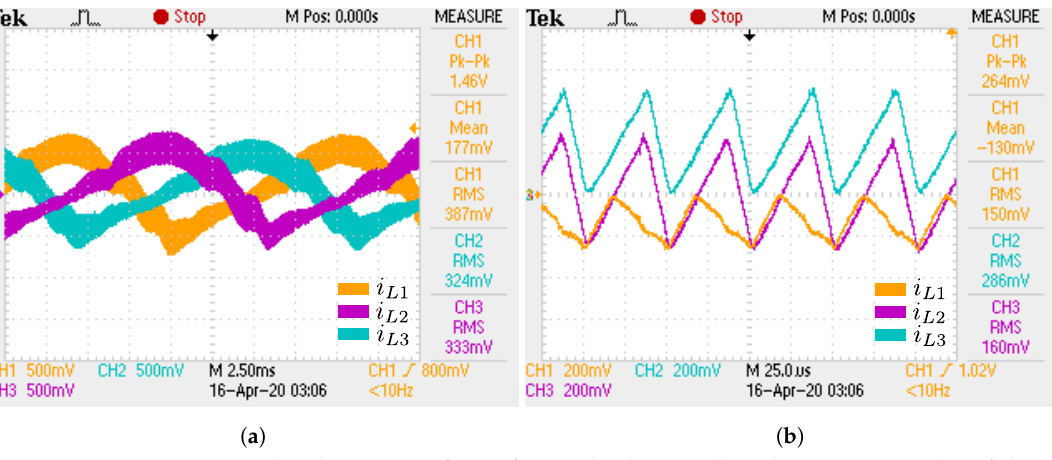
Figure 29. Experimental inductor waveforms for RC load case: ( a ) Inductor currents (25A/V); ( b ) Details of inductor currents